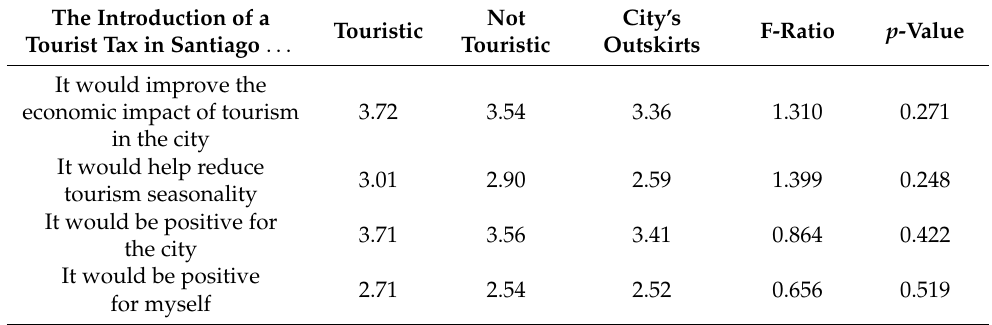
Table 6. Perception of the implementation of the tourist tax according to the resident’s